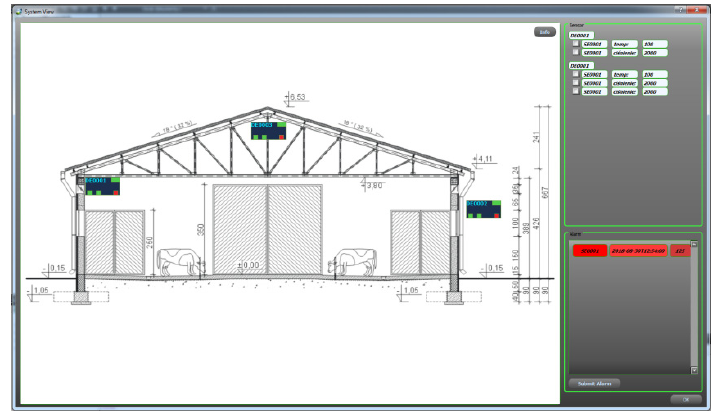
Figure 6. Part of the user interface.